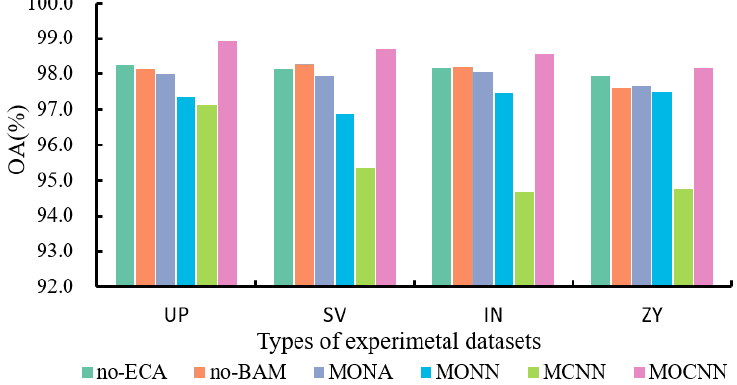
Figure 12. Results of ablation experiments on different types of